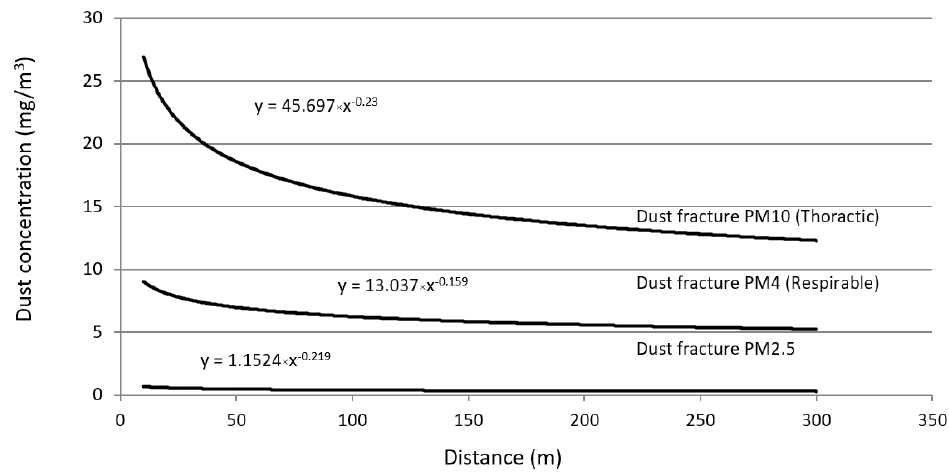
Figure 24. Characteristics and equations of PM10, PM4, and PM2.5 dust concentration for a coal face, depending on the distance from a dust source, developed on the basis of in situ tests.